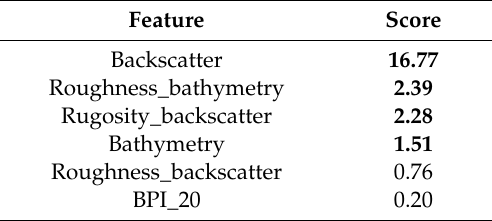
Table 2. Output from Random Forest selection algorithm. The first four bold scores (all greater than the threshold, which we defined as 1.5) are the most important features to identify sediment